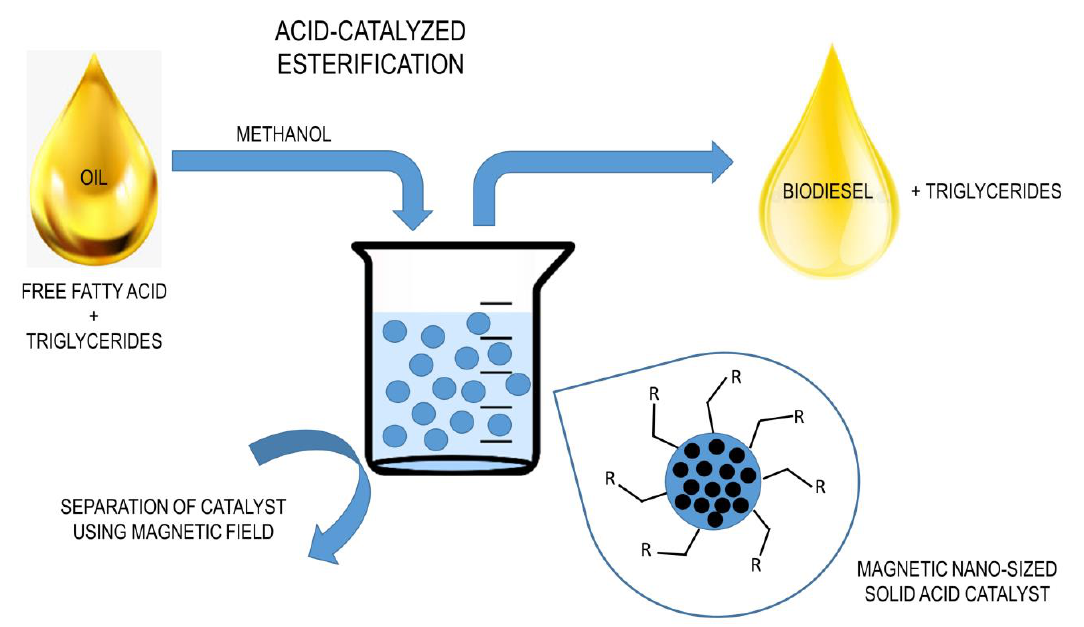
Figure 4. Scheme of magnetic solid acid-catalyzed esterification for biodiesel production.